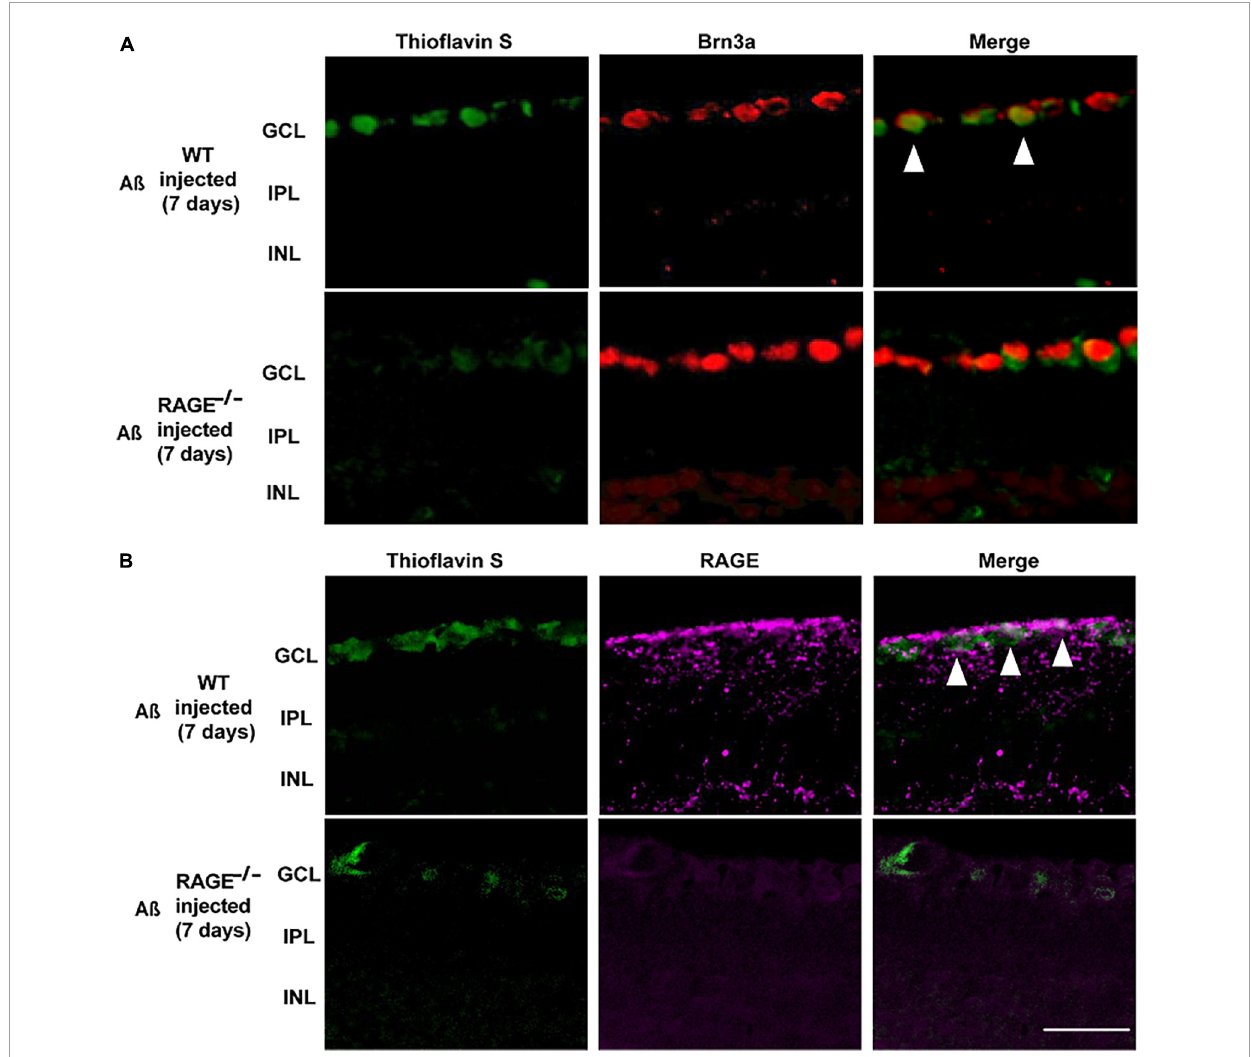
FIGURE4 Increased labeling of Brn3a, RAGE, and Thioflavin S were identified in the retina following Aß injection. (A) Immunostaining of WT and RAGE − / − mice. Brn3a (red) was used to label RGCs. Thioflavin S (green) was used to stain Aß. Increased labeling of Brn3a and Thioflavin S in the WT retina was observed 7 days after Aß injection ( n = 3). (B) RAGE upregulation (magenta) was observed in the GCL of WT mice, 7 days after Aß injection. Increased labeling of thioflavin S and RAGE was observed in the GCL of WT retina, 7 days after Aß injection ( n = 3). The scale bar is 50 µ